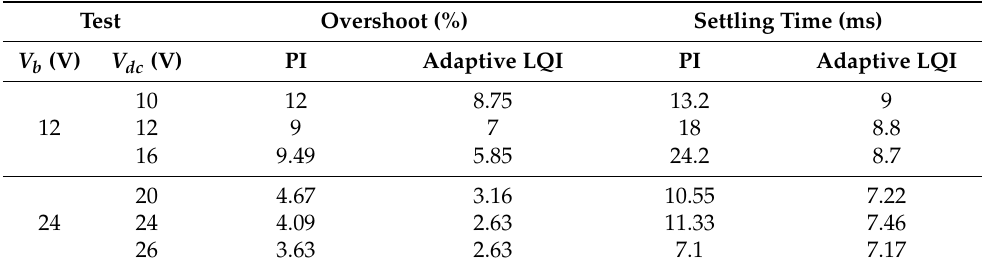
Table 4. Dynamic performance of experiments for bus voltage